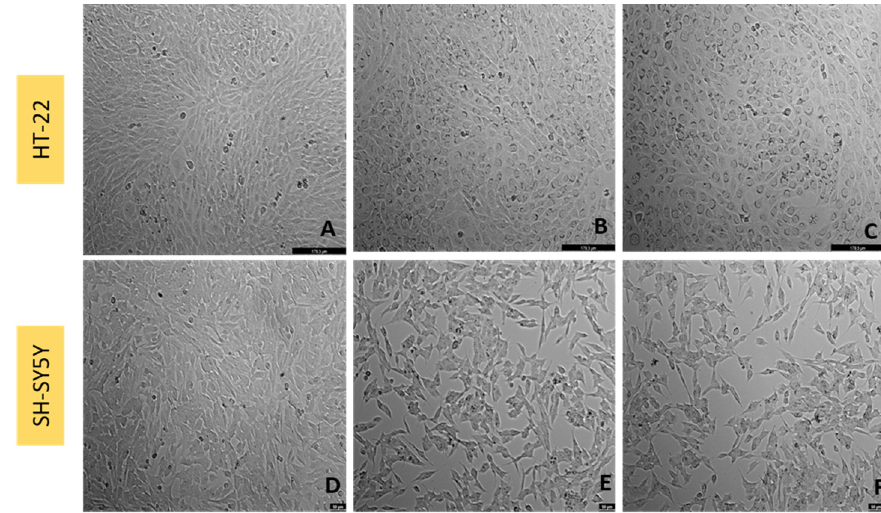
Figure 9. Effect of 48 h-incubation of ( A ) 236 μ M of corticosterone and ( B ) 35 μ M of corticosterone , in combination with 0.01–20 μ M of mirtazapine, determined by MTT assay. The results represent the mean ± SEM of 3–6 independent experiments, expressed as the percentage of the vehicle (100%).